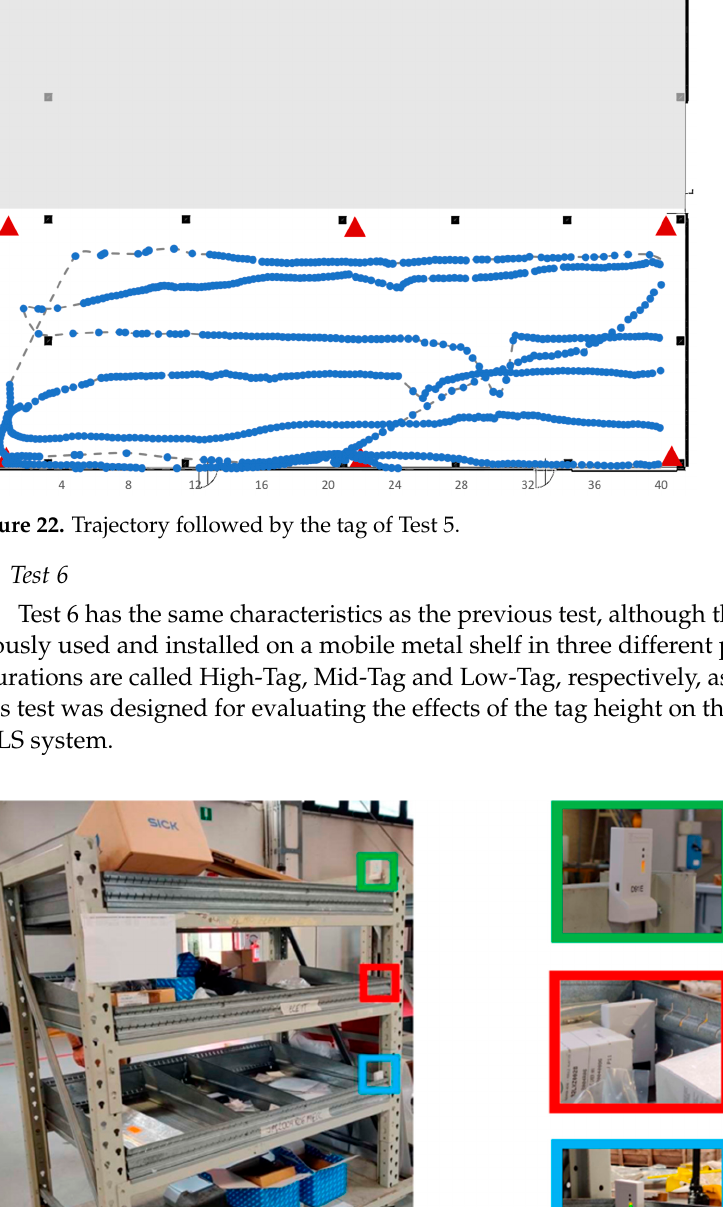
Figure 21. Trajectory followed by the tag in Test 4.